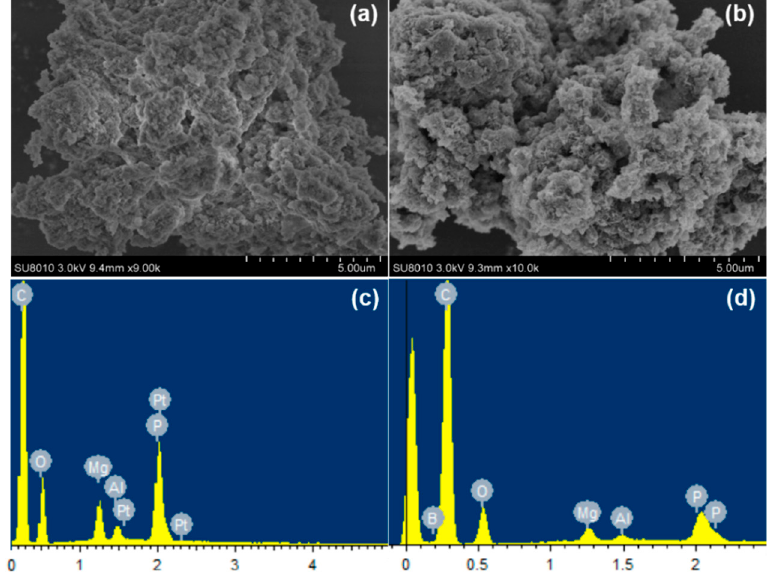
Figure 9. SEM-EDS images of ( a , c ) PP/20 w t% APP-LDHs and ( b , d ) PP/20 wt % APP-LDHs/2 wt % ZB composites char residue after combustion.